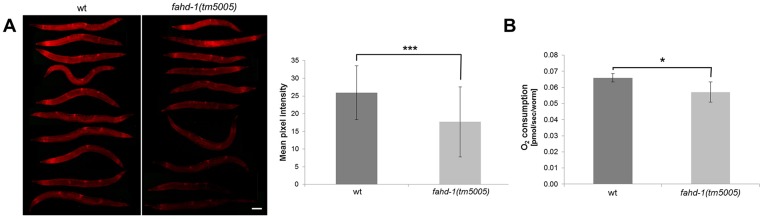
Mitochondrial dysfunction in fahd-1(tm5005) C. elegans.(A) 3-day old fahd-1(tm5005) and wild-type C. elegans were incubated with 100 nM TMRE overnight. Left panel: fahd-1(tm5005) animals exhibit a decreased mitochondrial membrane potential as shown by fluorescence microscopy. Representative images are shown. Size bar = 100 μm. Right panel: For quantification of the pixel intensities, fluorescence pictures were analyzed using ImageJ (25.93 ±SD 7.61 for wt vs. 17.69 ±SD 9.87 for fahd-1(tm5005); p = 0.0005; N = 30). (B) Oxygen consumption rate was determined in wild-type and fahd-1(tm5005) animals by Oxygraph 2K measurement and the basic respiration rate was determined. In fahd-1(tm5005) animals this parameter is significantly reduced (0.0659 ±SD 0.0026 pmol sec-1 worm-1 for wt vs. 0.0.0571 ±SD 0.0062 pmol sec-1 worm-1 for fahd-1(tm5005); p = 0.0475; N = 4).